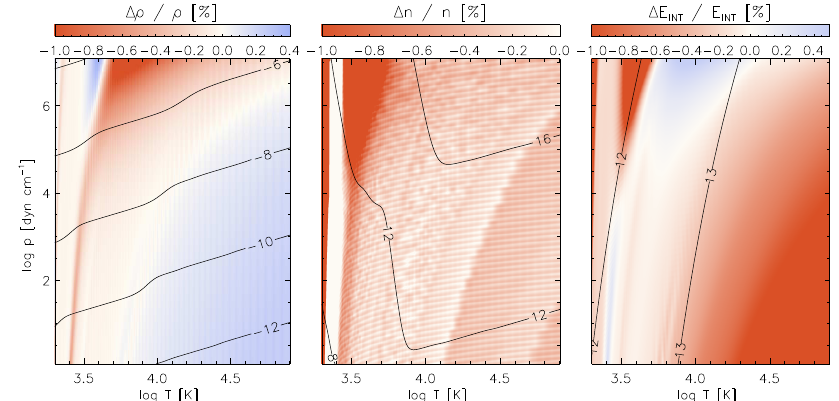
Figure 5. Blow-up of Fig. 4 in the low-pressure and low-temperature region relevant for the near-surface convection. The fragments of the contour lines from Fig. 4 are added.